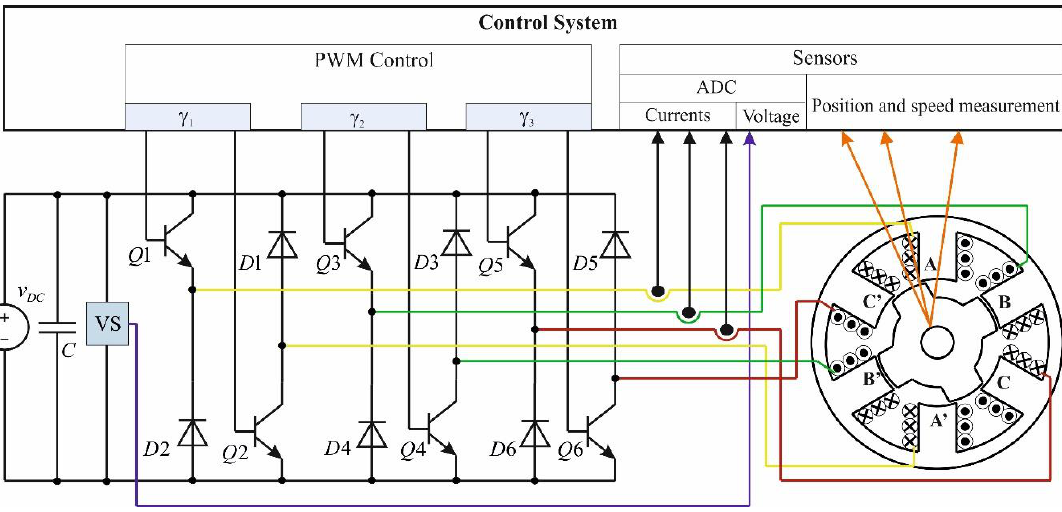
Figure 1. Switched reluctance drive topology.